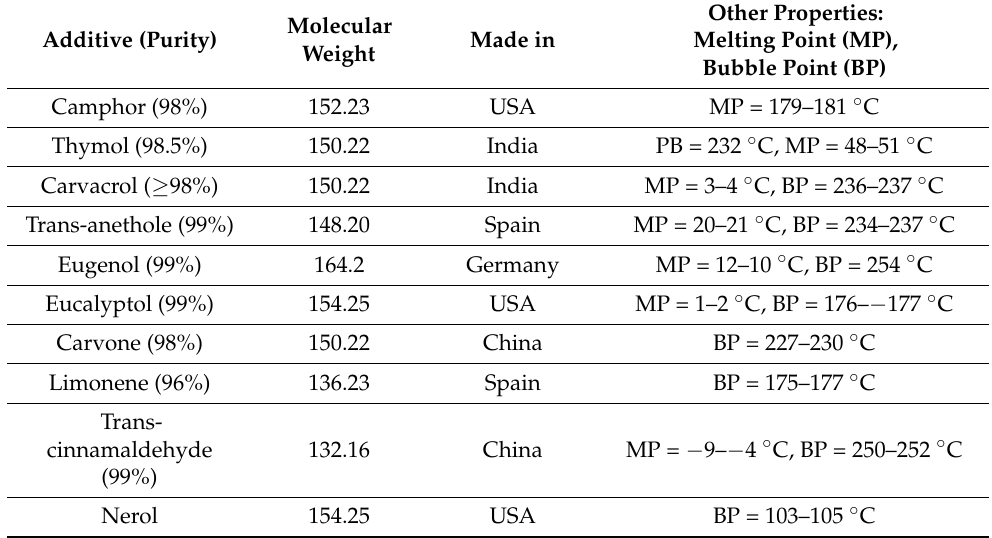
Table 4. The properties of essential oils blended with